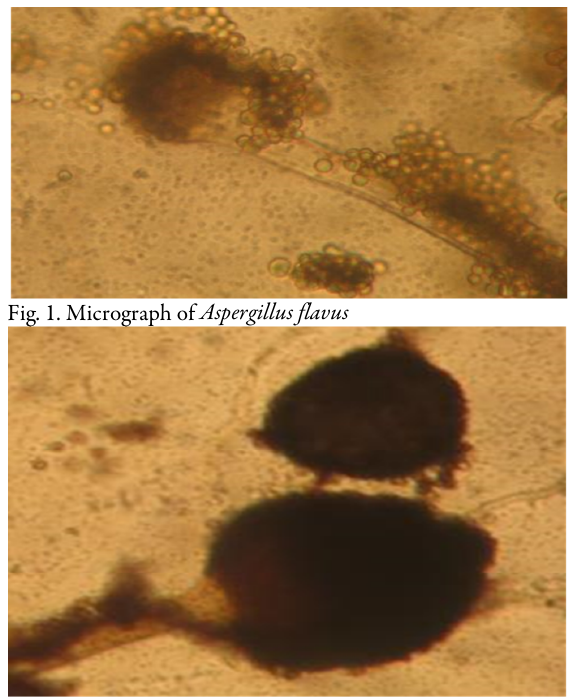
Fig. 2. Micrograph of Aspergillus